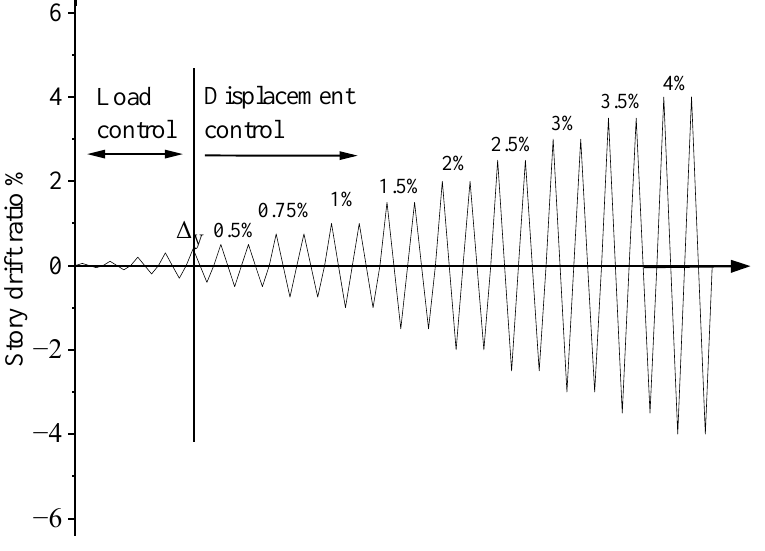
Figure 6. Cyclic loading of S − 4 [46].